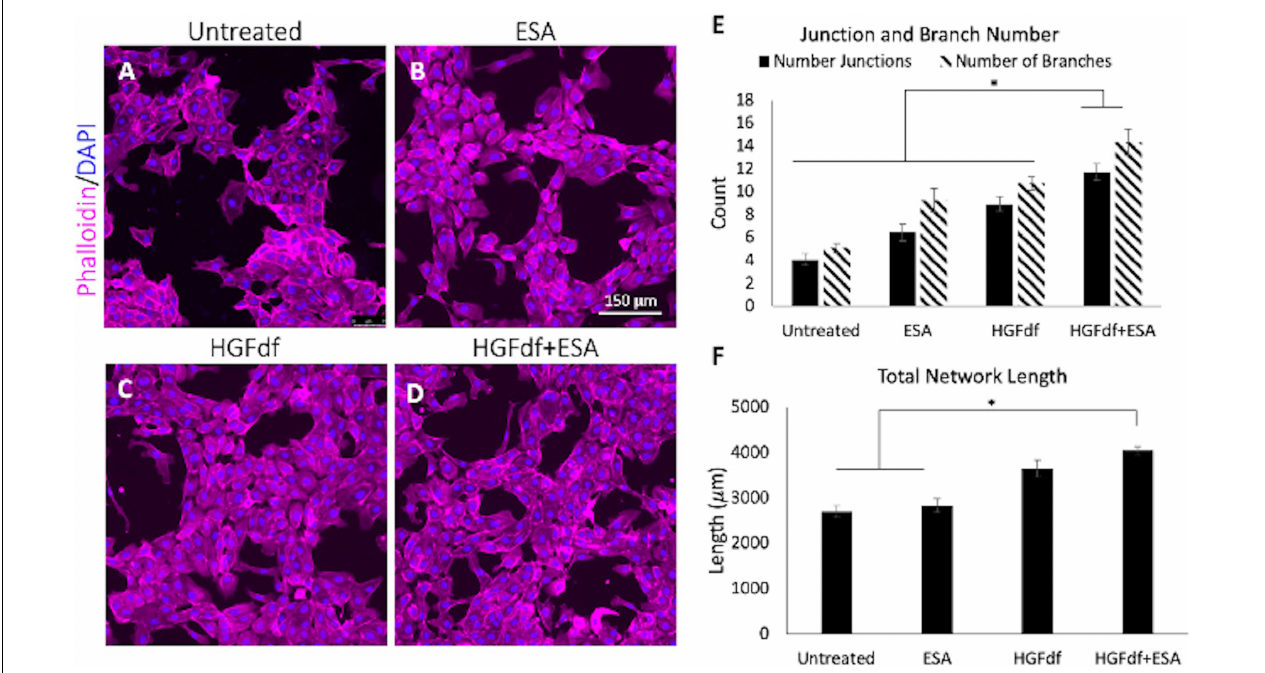
FIGURE 1 | Assessment of in vitro angiogenesis. Human umbilical cord vein endothelial cells were treated with (A) untreated, (B) engineered stromal cell-derived factor 1 α (ESA), (C) engineered dimeric fragment of hepatocyte growth factor (HGFdf) or (D) a combination of HGFdf and ESA. The extent of network formation (E,F) was evaluated in all groups. Pairwise student t -test with Bonferroni’s correction, * p < 0.05 (Steele et al.,